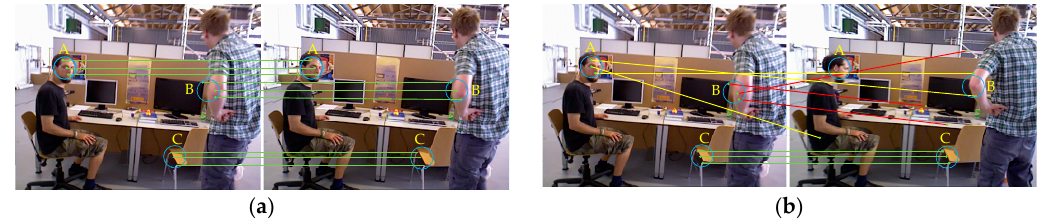
scene. ( a ) Feature matching is performed using two consecutive image frames. Since only a small movement occurs in the dynamic region, the A, B and C regions can achieve excellent feature matching. ( b ) Feature matching between two consecutive image frames is achieved by the sliding window model. Due to the obvious movement of the dynamic region, the feature matching of region A and B is wrong, and the matching of region C is still correct.